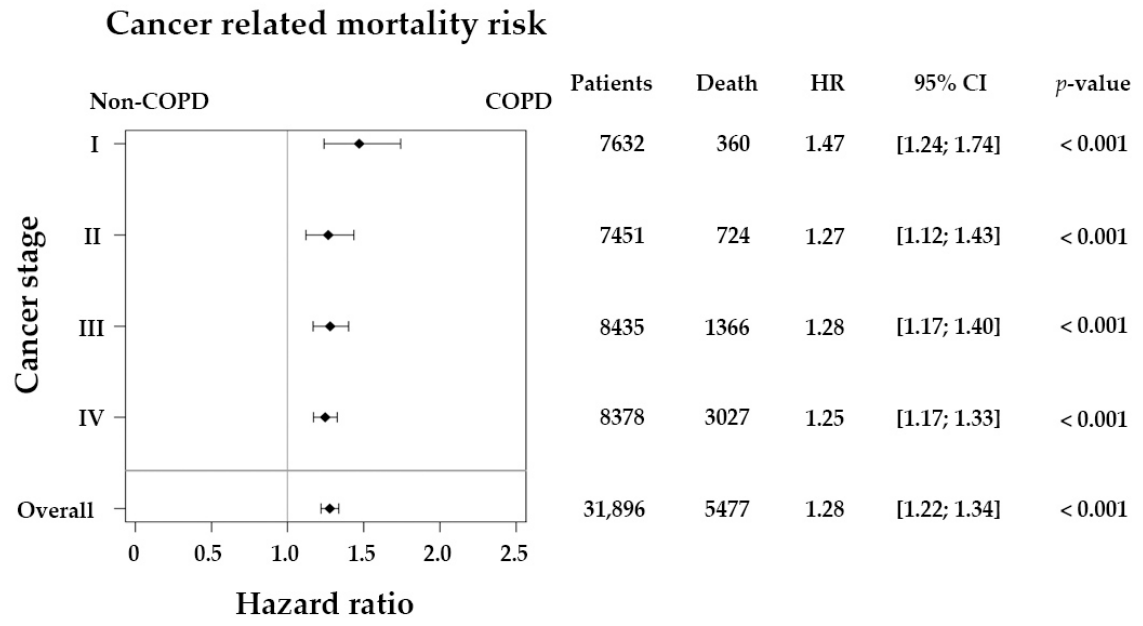
Figure 3. Subgroup analysis of cancer-related mortality with Cox regression model adjusted for sex and age-group by cancer stage, without propensity score matching. Total 31,896 patients with colorectal cancer were followed up for 5 years. The forest plot displays adjusted hazard ratios (HRs) and 95% confidence intervals (CIs) between preexisting chronic obstructive pulmonary disease (COPD) patients and non-COPD groups with different cancer stages by multivariate anal- ysis.